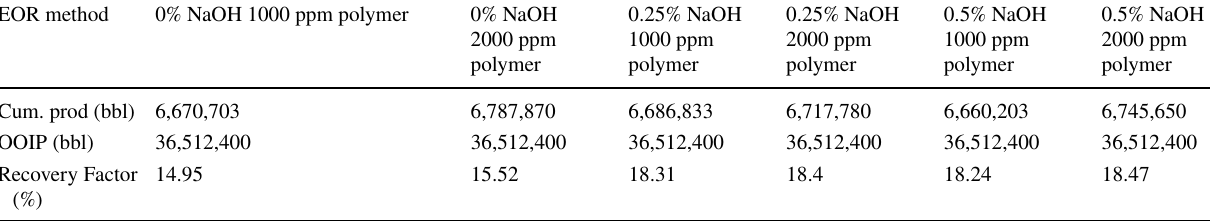
Table 3 Oil recovery rates for alkaline polymer flood scenarios EOR method